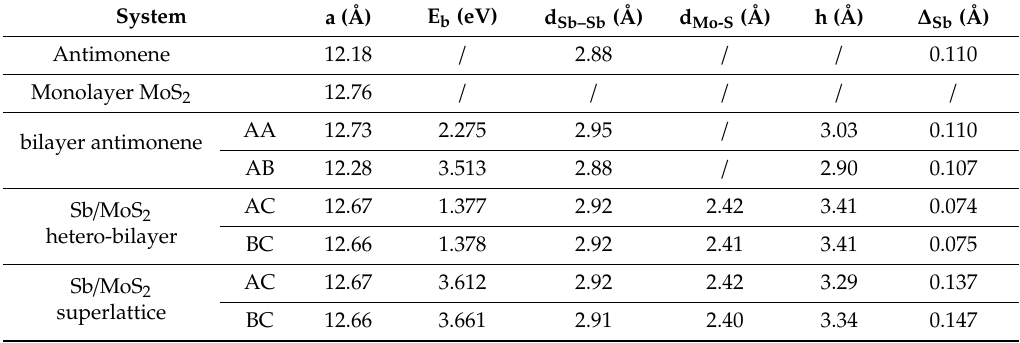
Table 1. Geometries and binding energies of antimonene and MoS 2 monolayer, antimonene bilayer, Sb / MoS 2 hetero-bilayers and Sb / MoS 2 superlattice, including the bond length, interlayer distance of stacked layer structure (h) and the amplitude of bucking of the antimonene layers ( ∆ Sb